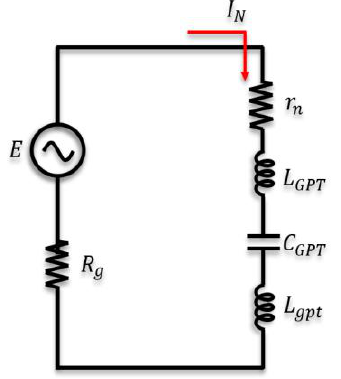
Figure 9. Equivalent circuit of current flowing to primary side of GPT in response to 1-wire ground fault.